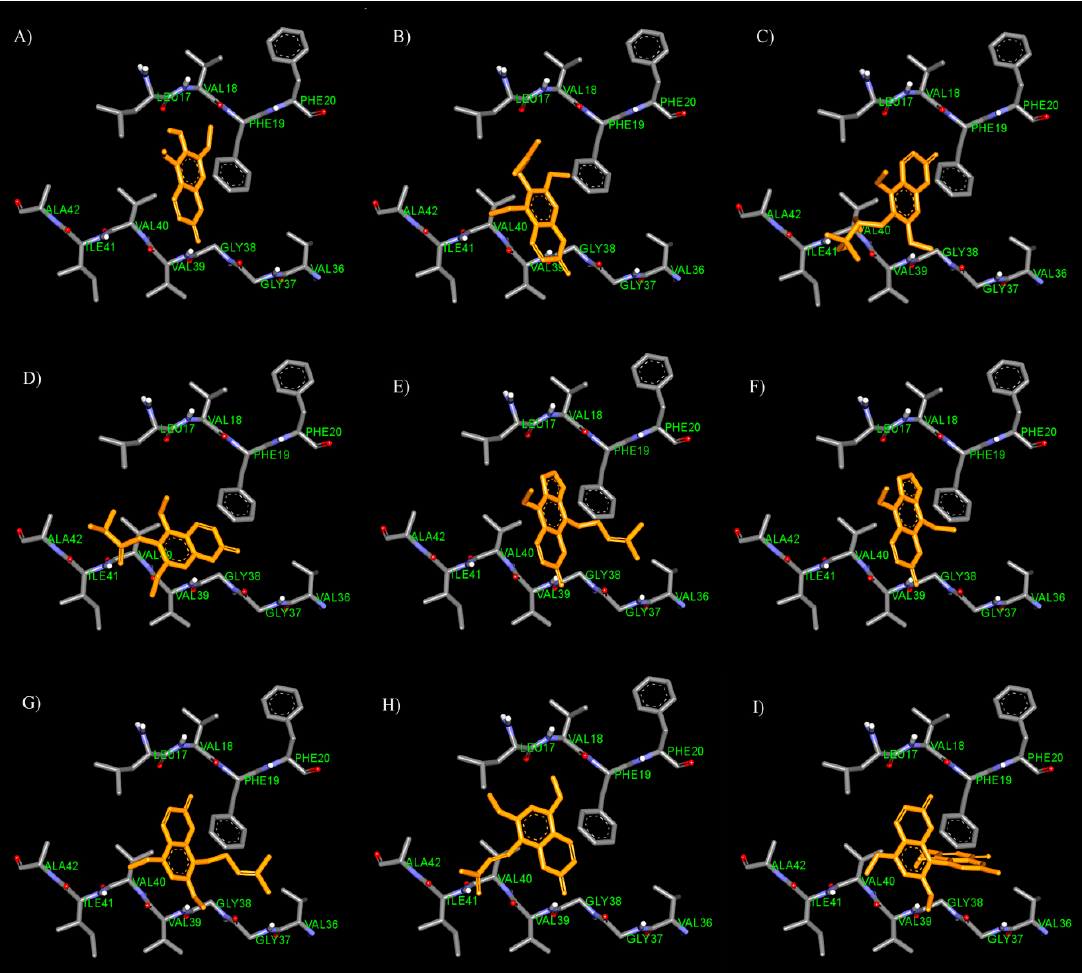
Figure 3. Binding mode for interactions of fraxinol ( A ), toddaculin ( B ), toddalolactone ( C ), toddanone ( D ), phellopterin ( E ), isopimpinellin ( F ), artanin ( G ), toddalenone ( H ), and toddacoumaquinone ( I ) docked into A β 1–42 fibrils.